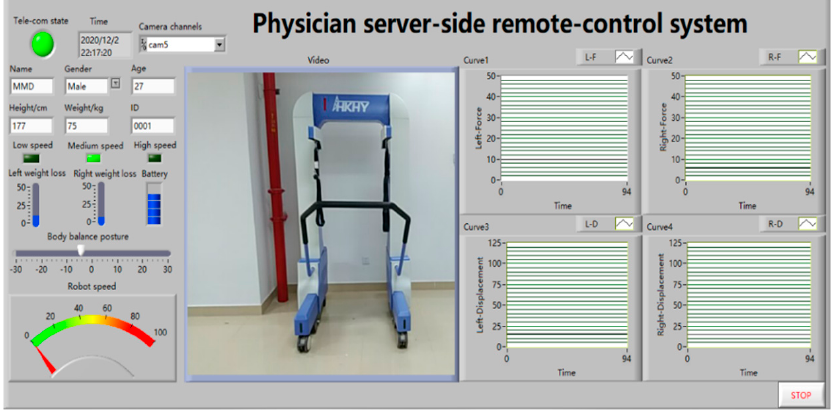
Figure 14. Remote communication success diagram of the doctor server computer.